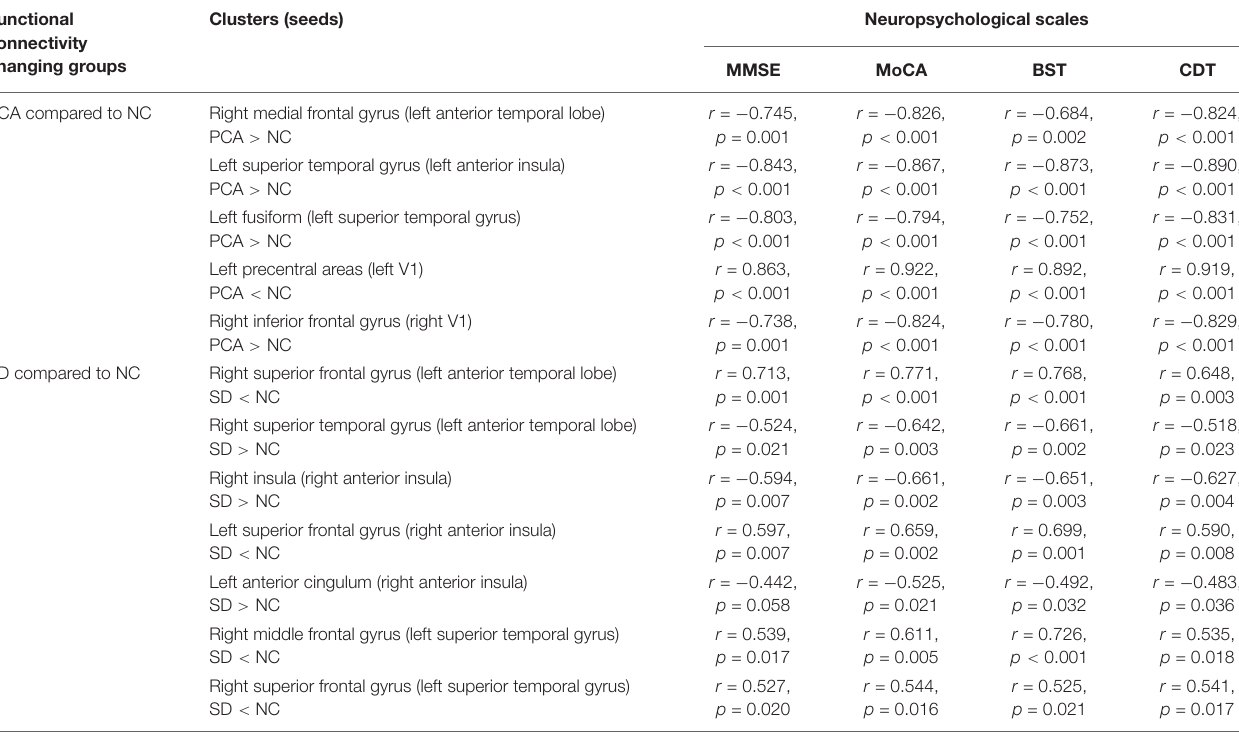
TABLE 4 | Partial correlation analysis between functional connectivity intensity and neuropsychological